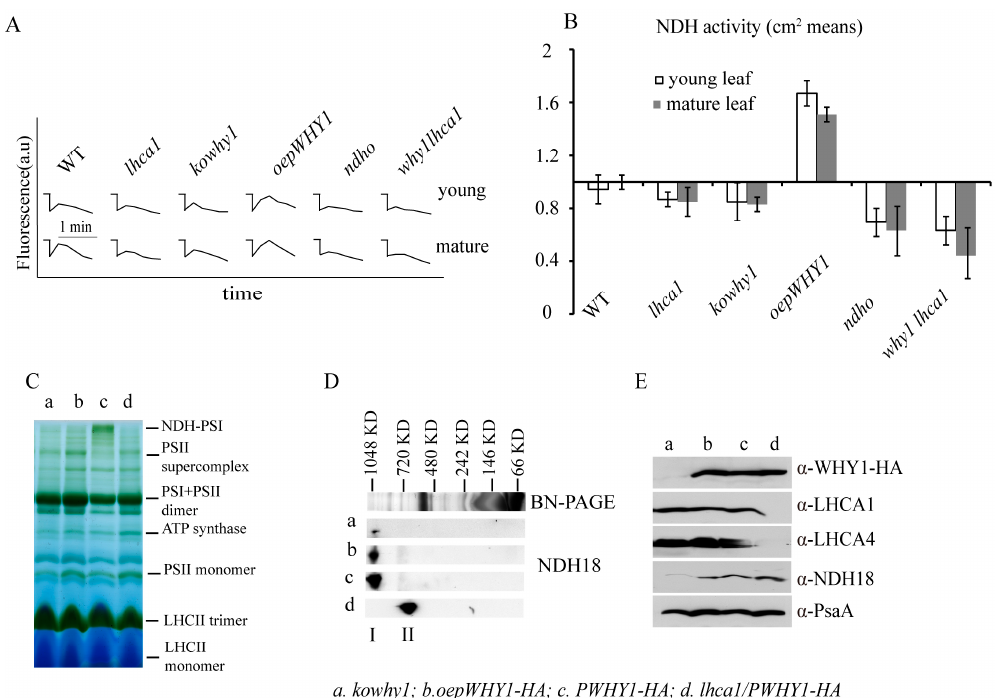
Figure 5. The stability of NDH-PSI complexes of thylakoid membranes and NDH activities in the different WHY1 and lhca1 mutants. ( A ) Determination of NDH activity by chlorophyll fluorescence analysis. Five-week-old plants including different WHY1 and lhca1 mutants, why1lhca1 double mutant and wild-type (WT) were illuminated for 5 min with AL (200 µ mol m − 2 s − 1 ). After illumination, the subsequent transient increase in chlorophyll fluorescence were recorded as an indicator of NDH activity (a.u.; arbitrary units). The fluorescence levels were standardized by the Fm level. Curves shows trace of chlorophyll fluorescence in mutants and WT plants. ndho line was used as positive control; ( B ) Quantification of NDH activity measured in ( A ). The transient increase in chlorophyll fluorescence in mutants was quantified by comparing the peak area with that of WT. The peak area of WT was set as 1. Data presented are the mean of ± SE ( n = 5–6); ( C ) Blue Native PAGE of thylakoid membrane, Band I is the NDH-PSI supercomplex detected in PWHY-HA line; ( D ) 2D SDS-PAGE separation and immunodetection of NDH-PSI supercomplex containing NDH18 protein (I) and monomer NDH18 (II); ( E ) Immunodetection of thylakoid membrane, the antibody against to HA peptide, LHCA1, LHCA4, NDH18 (provided by Shikanai group, Japan) and PsaA in kowhy1 (a), oepWHY1-HA (b), PWHY1-HA (c), and PWHY1-HA in lhca1 background, lhca1/PWHY1-HA (d).